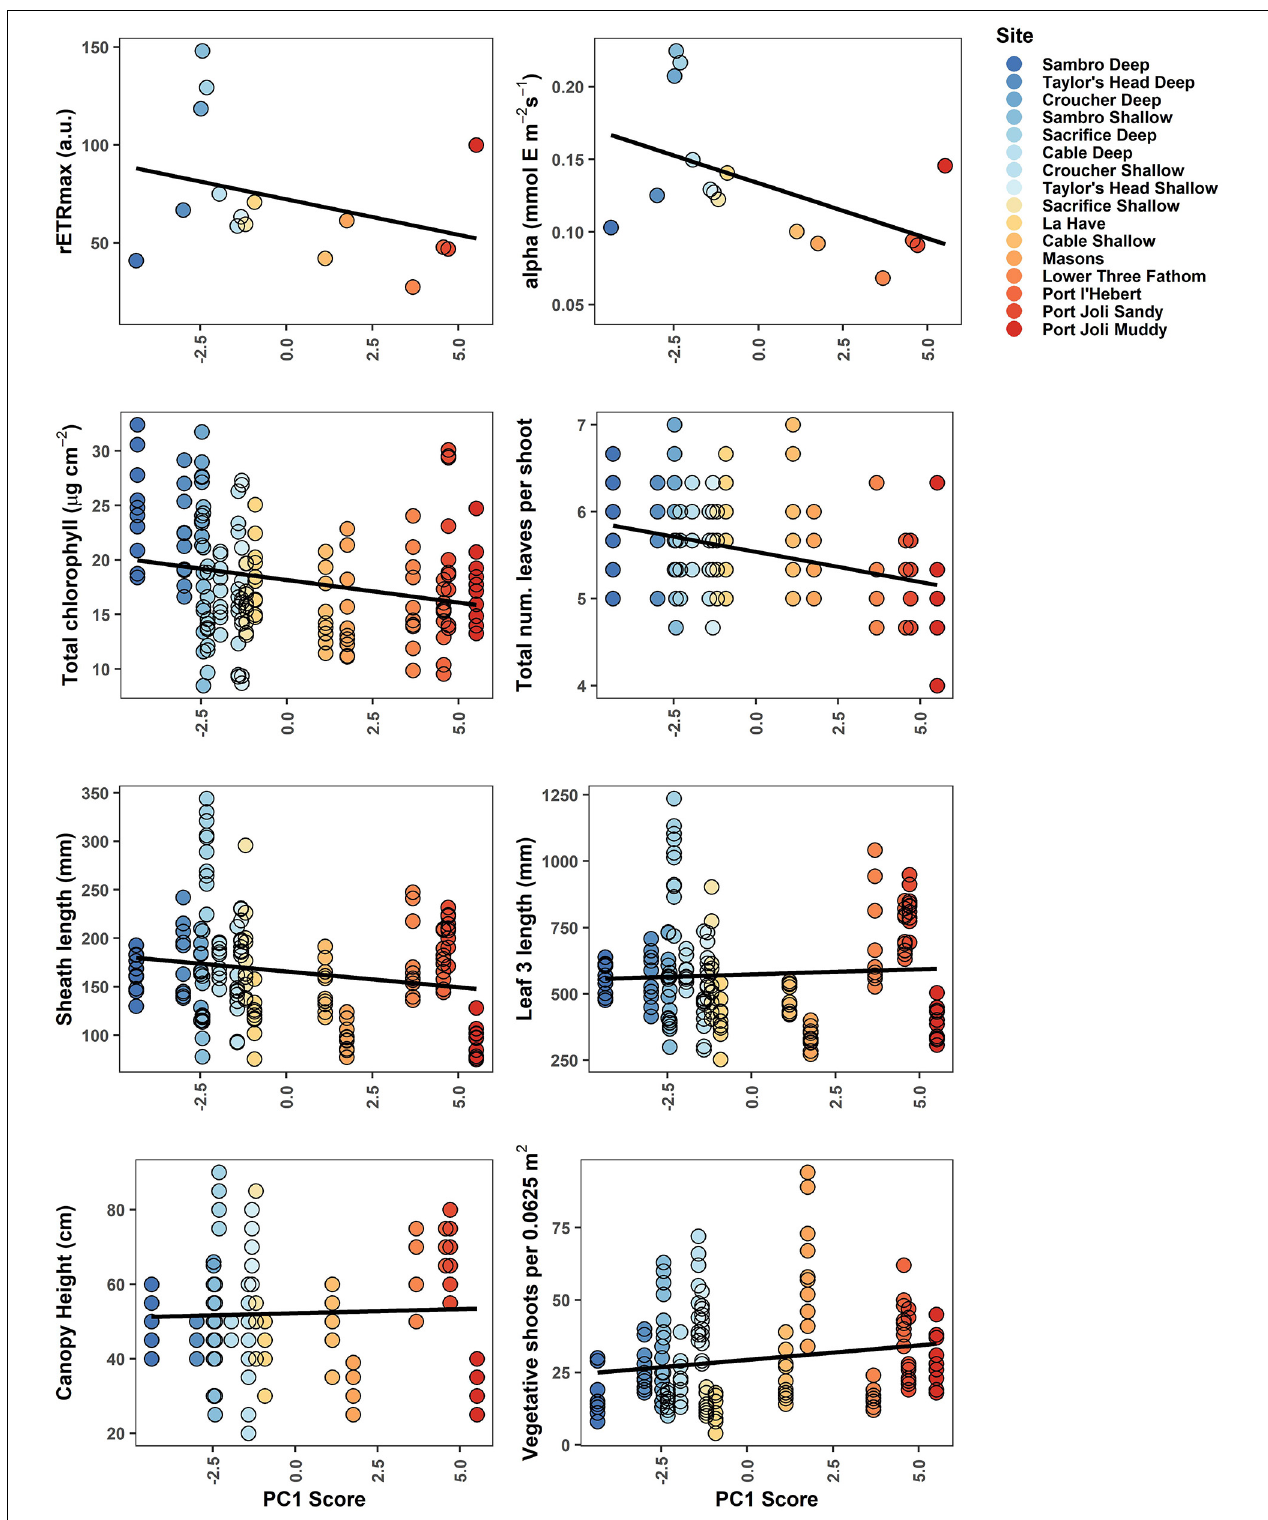
FIGURE 4 | Biological metrics of production plotted against each site’s score along the first principal component in the PCA of environmental variables. The least-squares fit straight line is given in black. Point color corresponds to Figure 2 , demonstrating a gradient from cooler, deeper sites (blue) to warmer, shallower sites with higher light attenuation